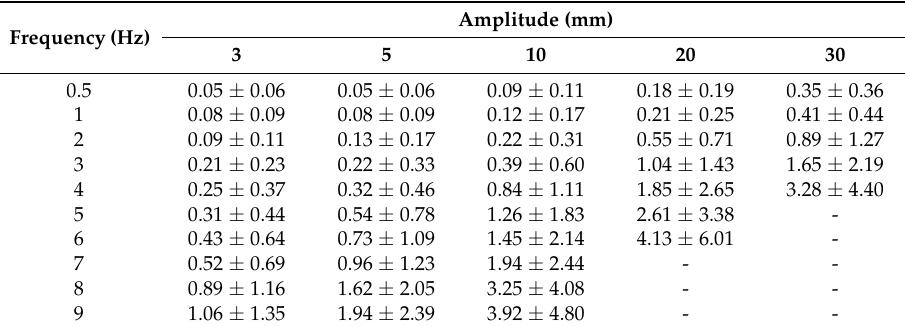
Figure 7. Oscillation displacements of different segments (amplitude: 10 mm; frequency: 0.5–9 Hz) obtained through the wMPS. Horizontal lines indicate the real oscillation amplitude. ( a ) Oscillation displacements of 0.5 Hz segment, the sampling rate can reconstruct the displacement signal almost perfectly; ( b ) oscillation displacements of 1 Hz segment, the displacement signals described a nearly ideal sinusoidal oscillation; ( c ) the amplitude of displacement vibration is no longer consistent, but the error is small, indicating that the sampling rate of 2 Hz can still approximately reconstruct the original signal; ( d ) the error of the result obtained is still small, and the sampling rate of 3 Hz also meets the requirements; ( e ) oscillation displacements of 4 Hz segment; ( f ) oscillation displacements of 5 Hz segment; ( g ) oscillation displacements of 6 Hz segment; ( h ) oscillation displacements of 7 Hz segment; ( i ) oscillation displacements of 8 Hz segment; ( j ) oscillation displacements of 9 Hz segment. From ( e ) to ( j ), the error gradually increases with the increase of sampling rate, and the displacement signal can no longer be accurately reconstructed. Table 1. Absolute deviation of amplitude of different